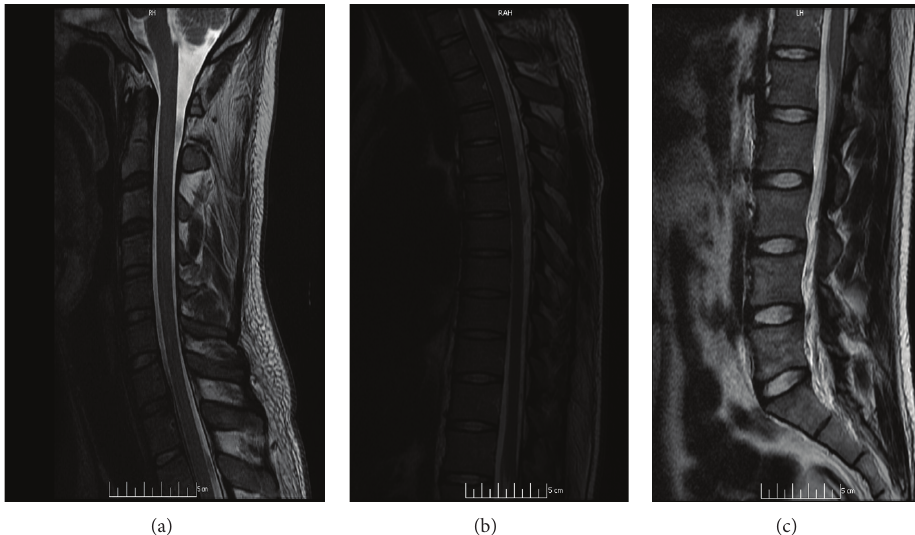
Figure 2: Sagittal MRI of the cervical, thoracic, and lumbosacral spinal cord (T2W; (a) to (c)) was unremarkable without a demonstrable compressive